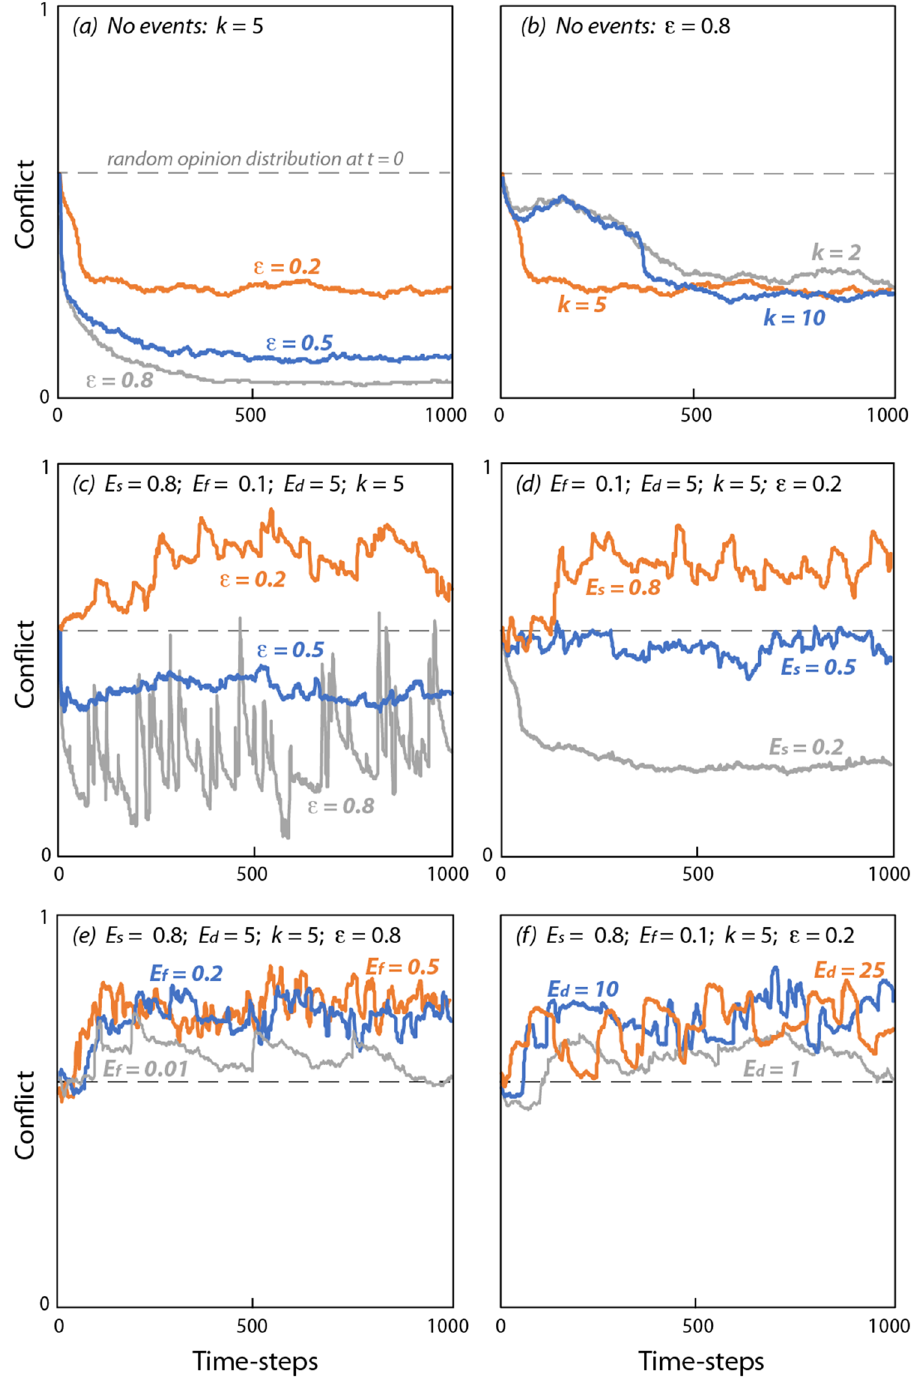
Figure 3. Conflict ( (cid:31) O t ) tracked over 1000 timesteps, starting from a uniform random distribution of opinions √ 3 = 0.577 ). Shown are dependencies on: ( a ) confidence threshold when there were no events; ( b ) ( � O 0 = 1 / average number of connections per individual per timestep when there were no events; ( c ) confidence interval when there were events; ( d ) event strength; ( e ) event frequency; and ( f ) event